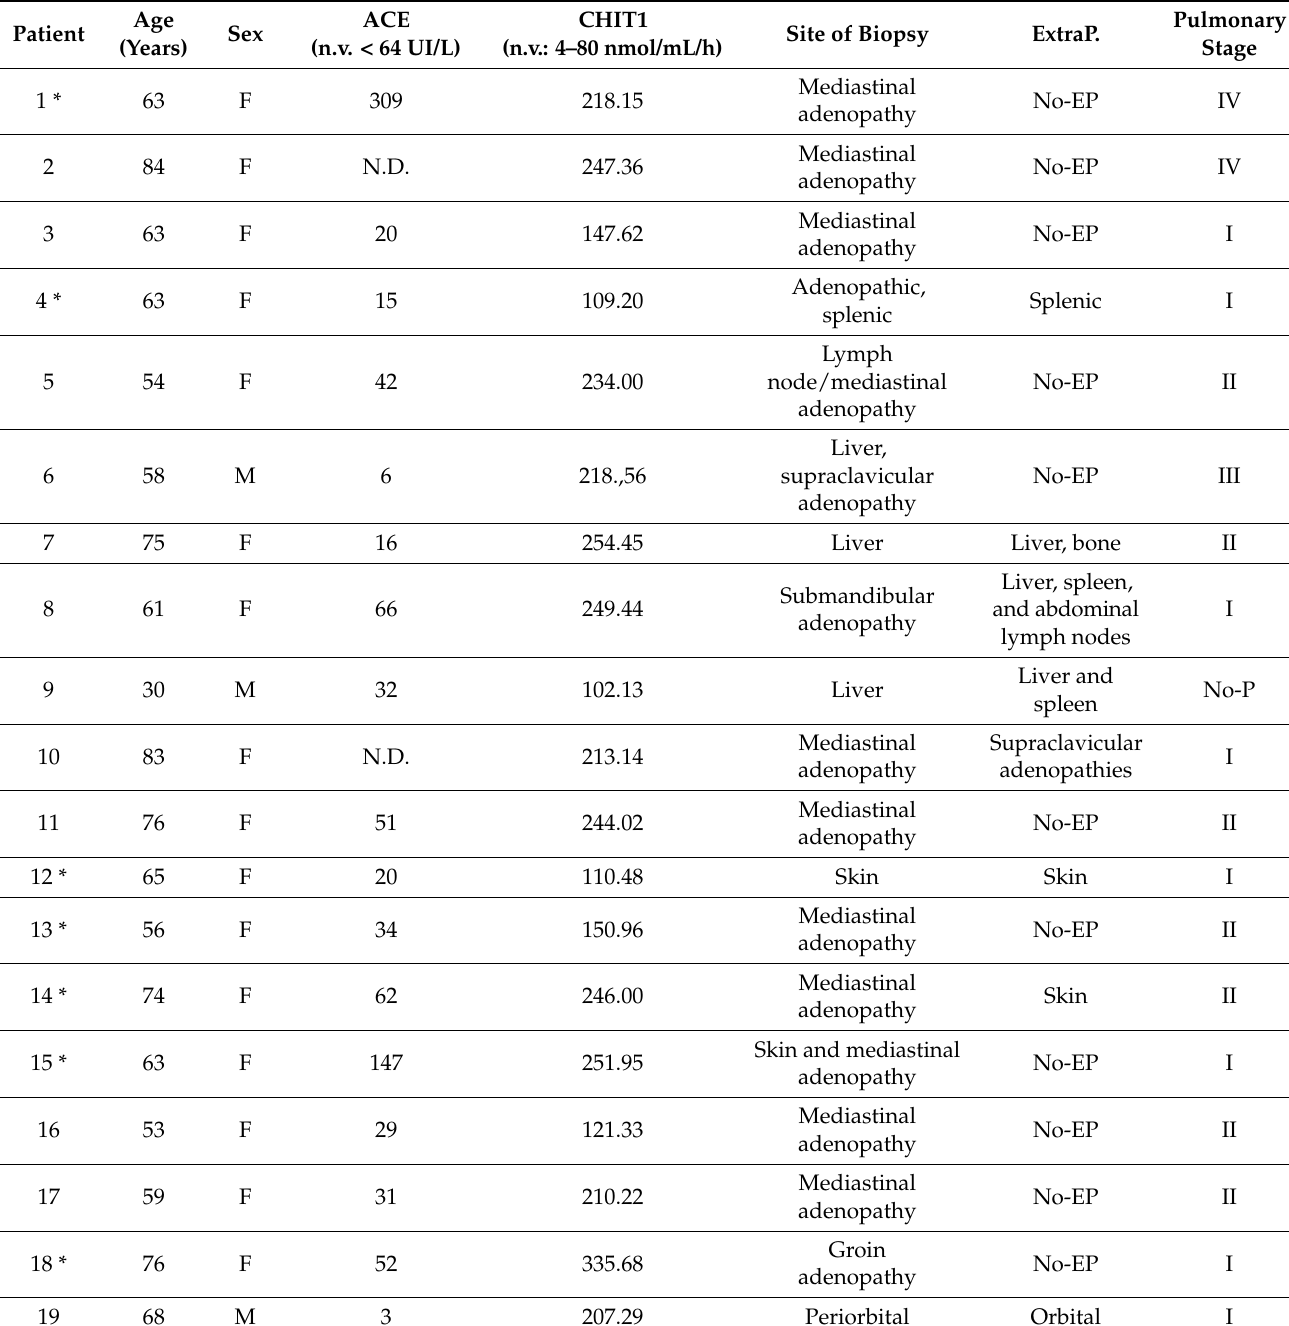
Table 1. Study Group 1 (Active sarcoidosis